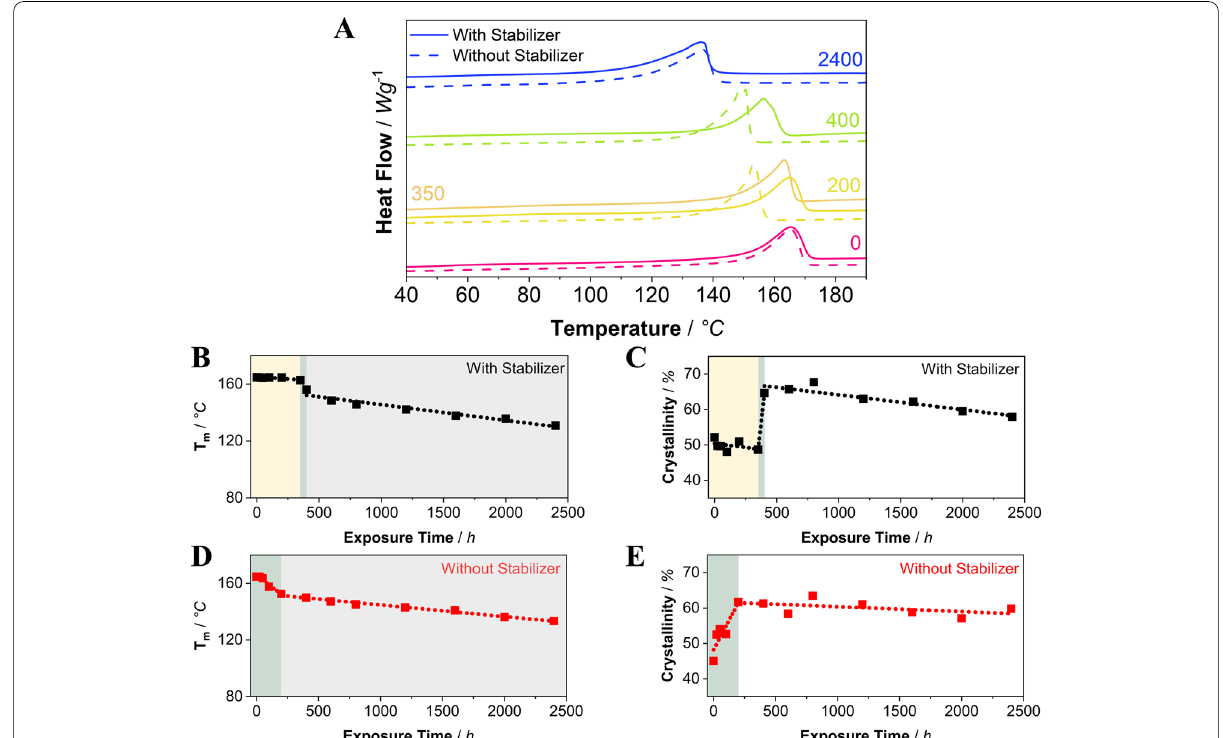
Fig. 3 A Melting curves of PP with (solid) and without stabilizer (dashed) for 0, 200, 350, 400 and 2000 h of weathering. Individual curves are shifted vertically for better comparability. B T m in °C and C crystallinity in % as a function of exposure time from 0 to 2400 h for PP with stabilizer. D T m and E crystallinity for PP without stabilizer. The induction phase is highlighted in yellow. Green marks the start of degradation while grey indicates on-going degradation with minor changes of T m and